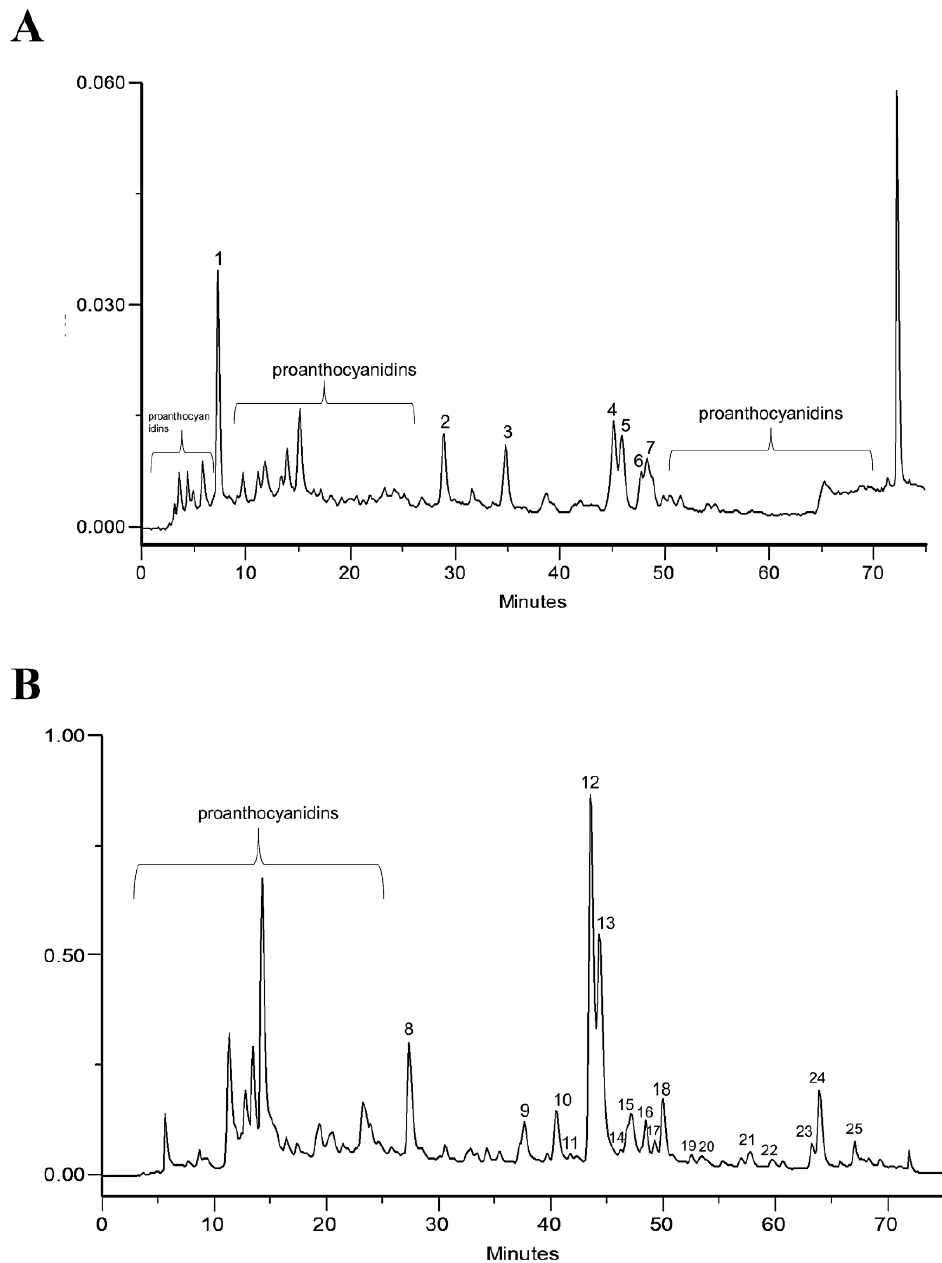
Figure 1. HPLC-PDA profile of A. eupatoria : ( A ) infusion and ( B ) ethyl acetate fraction. Both chromatograms were recorded at 280 nm.